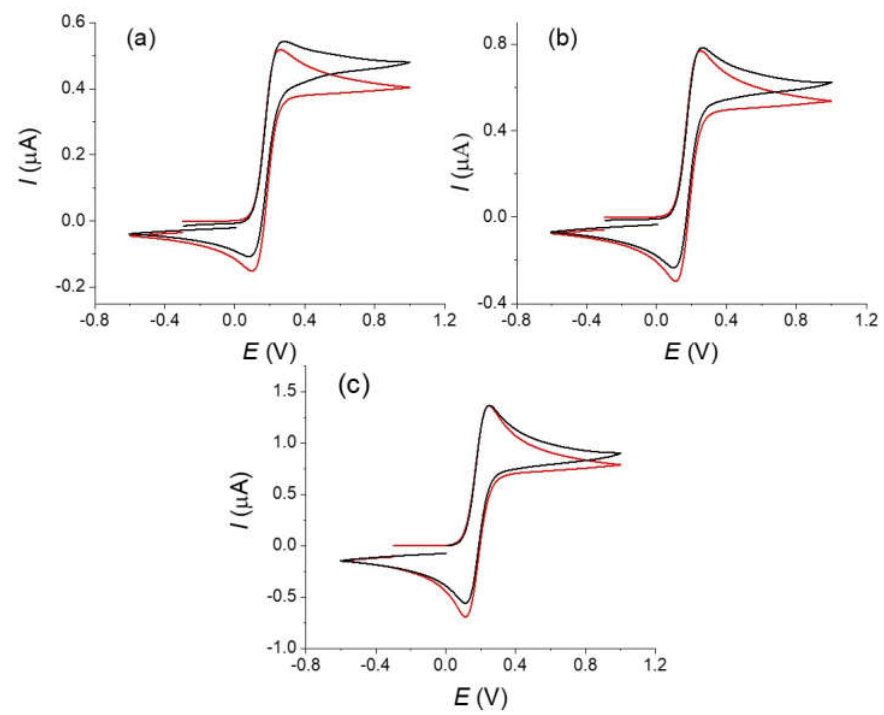
Figure 3. Simulation (red) and experimental curves (black) recorded on an oxidized fiber (type 3) of a 5.10 −3 mol L −1 solution of 1,1′-dimethanolferrocene in 0.1 mol L −1 H 2 SO 4 and 0.5 mol L −1 KCl. Scan a 5.10 − 3 mol L − 1 solution of 1,1 (cid:48) -dimethanolferrocene in 0.1 mol L − 1 H 2 SO 4 and 0.5 mol L − 1 KCl. rates ν = ( a ) 0.01, ( b ) 0.1, ( c ) 1 V s −1 . Parameters of the simulations; r = 4.5 µm; l = 0.9 mm; α = 0.5; E° Scan rates ν = ( a ) 0.01, ( b ) 0.1, ( c ) 1 V s − 1 . Parameters of the simulations; r = 4.5 µ m; l = 0.9 mm; = 0.175 V; k s = 0.025 s −1 . α = 0.5; E ◦ = 0.175 V; k s = 0.025 s − 1